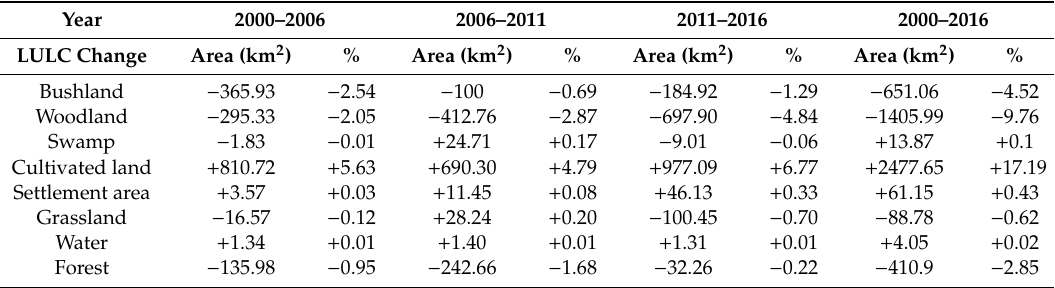
Table 9. Results of the LULC classification for 2000, 2006, 2011, and 2016 images showing the area changed and percentage at Wami